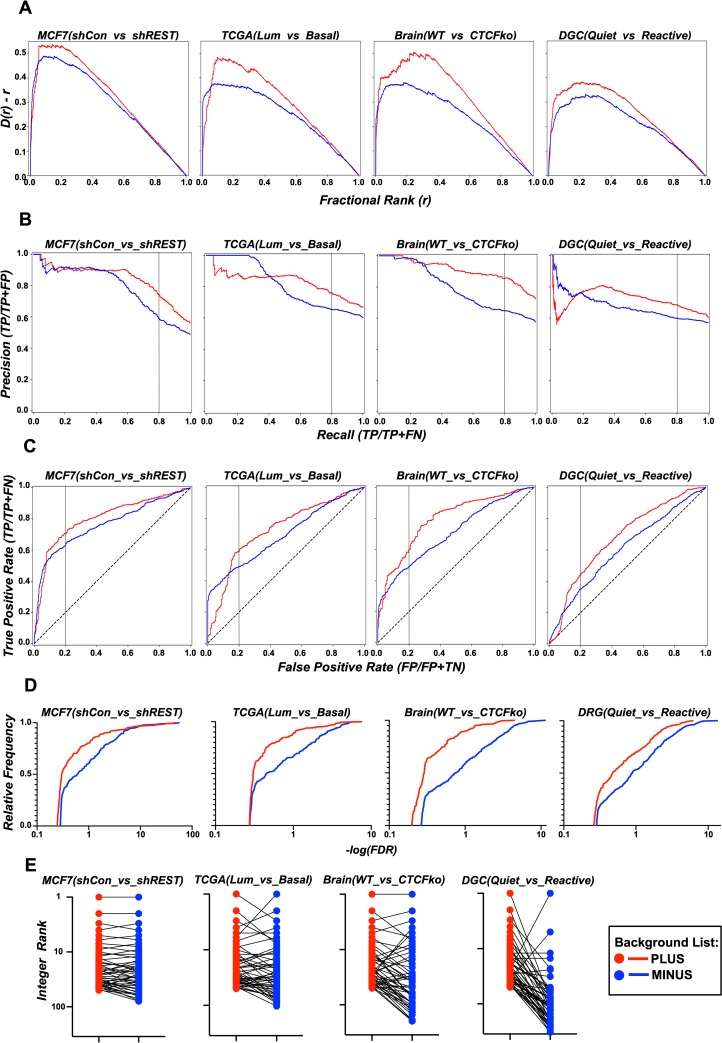
MAGIC requires a valid background gene list for optimal performance.(A) D(r)-r curves for the 4 datasets generated for MAGIC outputs in the presence or absence of a background list. Kolmogorov-smirnov statistics for the 2 curves: MCF7(shCon_vs_shREST); D = 0.10, p = 8.6x10-5. TCGA(Lum_vs_Basal); D = 0.15, p = 4.6x10-11. Brain(WT_vs_CTCFko); D = 0.26, p = 1.1x10-16. DGC(Quiet_vs_Reactive); D = 0.11, p = 3.9x10-9. (B) Precision Recall curves for MAGIC outputs in the presence or absence of a background list: MCF7(shCon_vs_shREST); 0.84 vs 0.78, TCGA(Lum_vs_Basal); 0.83 vs 0.81, Brain(WT_vs_CTCFko); 0.91 vs 0.71, DGC(Quiet_vs_Reactive); 0.72 vs 0.67. Black vertical line denotes 80% Recall (C) Receiver Operator Characteristics curves for MAGIC outputs in the presence or absence of a background list (unbalanced). (D) Emperical cumulative distribution for False Discovery Rates associated with MAGIC outputs in the presence or absence of a background list. For all datasets, Kolmogorov-smirnov p <10−4. (E) The integer ranks for the top 50 Factors called by MAGIC in the presence of a background list were compared to their ranks in the absence of a background list.